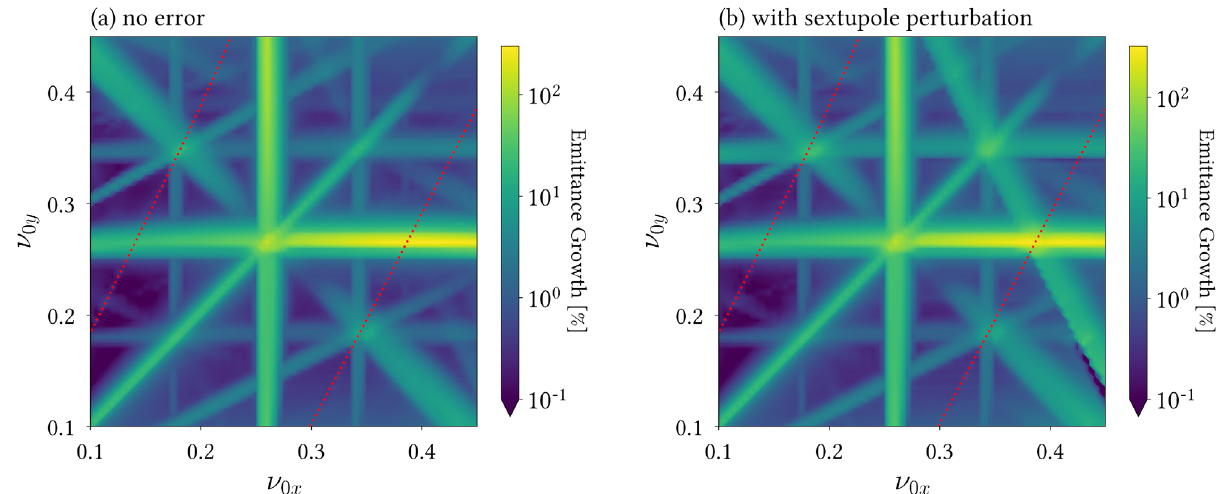
FIG. 26. Tune diagrams obtained from 2D W ARP simulations under the initial emittance ratio ε x = ε y ¼ 2 . Similarly to Fig. 8, we have used the matched Gaussian beam propagating through the sinusoidal focusing channel of 100 AG periods long. The ratio of the horizontal rms emittance to the vertical is fixed at 2.0 everywhere on the diagram. The beam current is maintained at the same value as assumed in Figs. 4 and 6. The red dotted lines represent the positions of the third-order coherent resonance bands defined by Eq. (8) with ð k; l ; n 0 Þ ¼ ð 2 ; − 1 ; 0 Þ , ð 2 ; − 1 ; 1 Þ and C ¼ 0 . 875 , both of which are invisible here. The left panel (a) shows the case where the external 3 force is completely linear. In the right panel (b), the external imperfection potential proportional to y 3 − 3 x 2 y has been switched on. The perturbation amplitude is set at 1% of the quadrupole focusing field ’ s. In this case, some particle losses occur near the low-tune boundaries (i.e., in the tail resonance region) of the third-order external-field-driven resonance